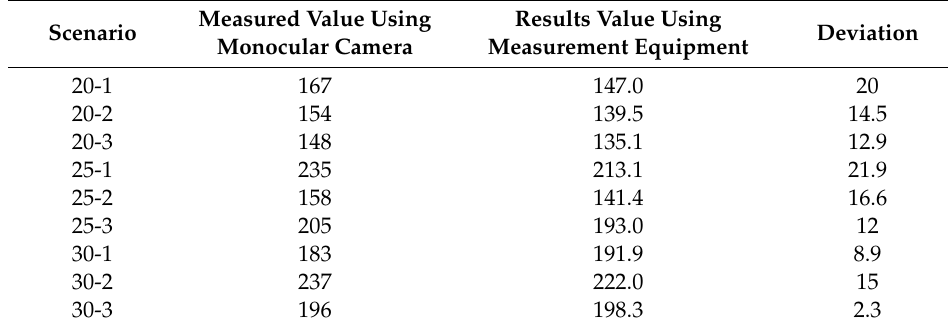
Table 10. Error factor by scenario of measured value using monocular camera vs results value using measurement equipment (CPFC), [cm].